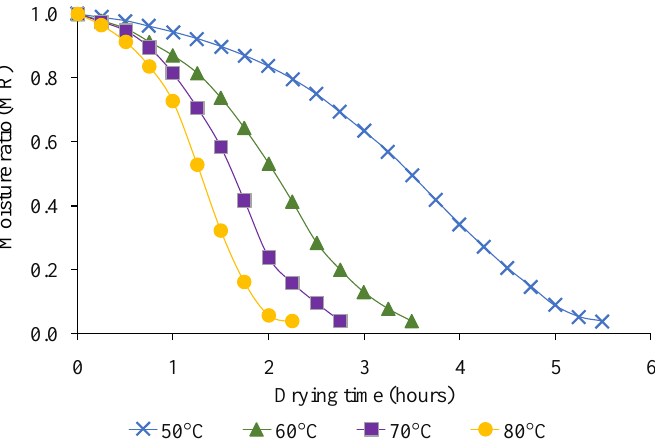
Figure 4. The change in moisture ratio at various temperatures by foam-mat drying.